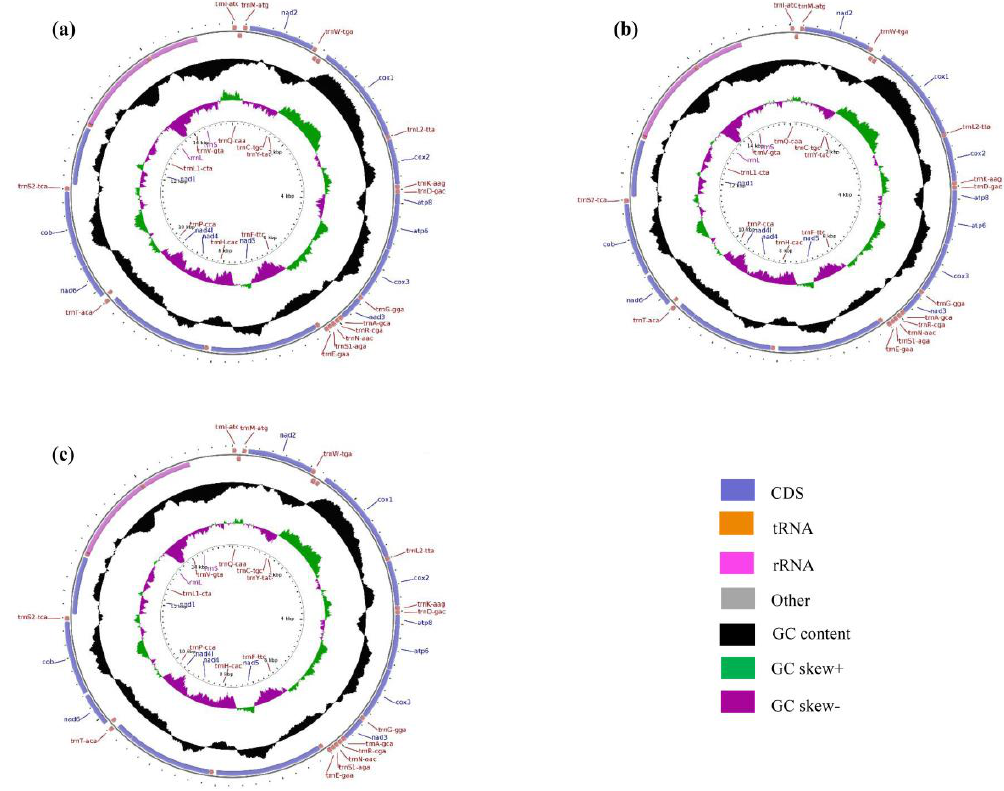
Figure 2. Circular map of the mitochondrial genomes of Thitarodes populations: SD ♂ × SD ♀ ( a ), GG ♂ × GG ♀ ( b ) and SD ♂ × GG ♀ ( c ).